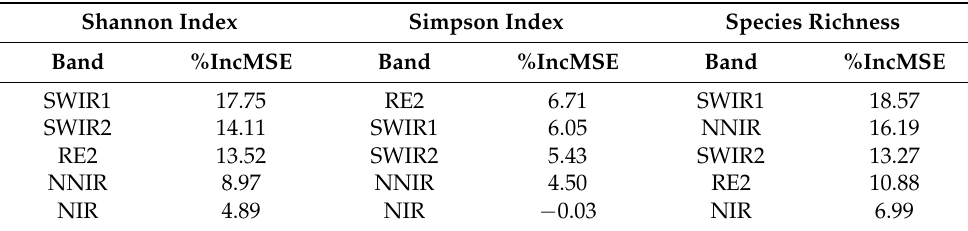
Table 5. Variable importance ranking for the Sentinel 2 image model under the Shannon Index, Simpson Index and the Species